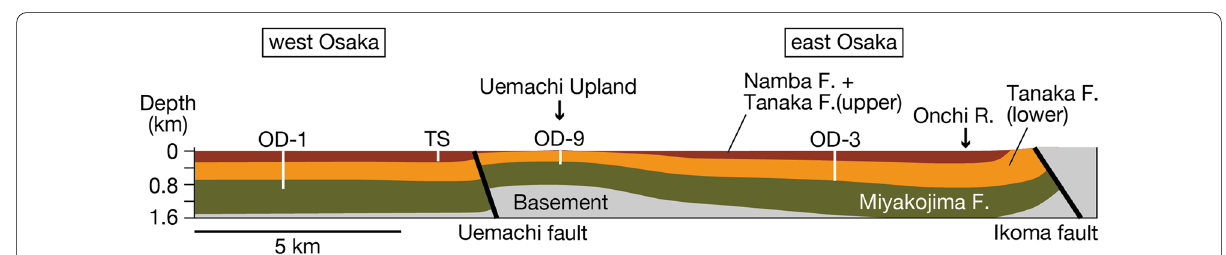
Fig. 3 Schematic E–W geological section through the Osaka Plain (Uchiyama et al. 2001)